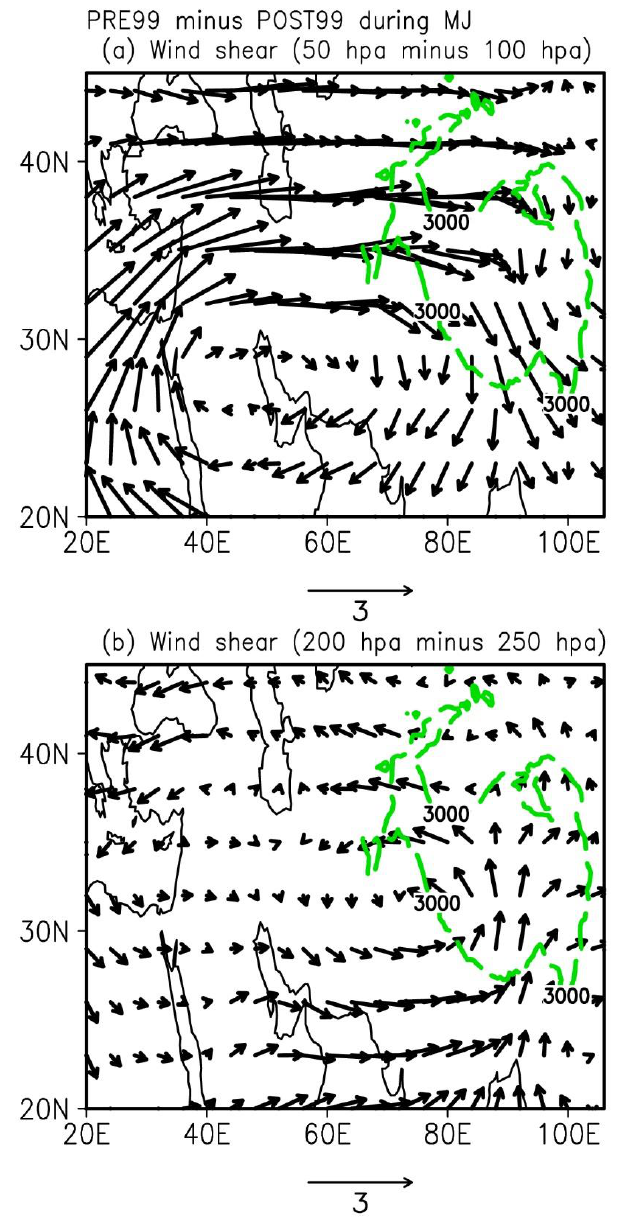
Figure 4. MJ averaged wind shear (in m/s) around 100 hPa and 250 hPa during PRE99 minus POST99 ( a ) 50 - 100 hPa; ( b ) 200 - 250 hPa.